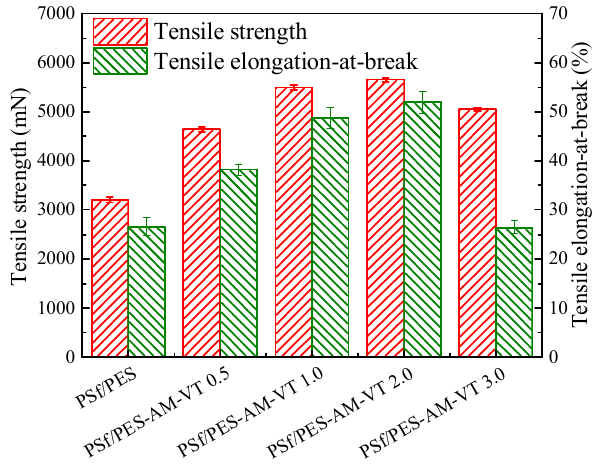
Figure 8. Mechanical properties of the neat and modified membranes.